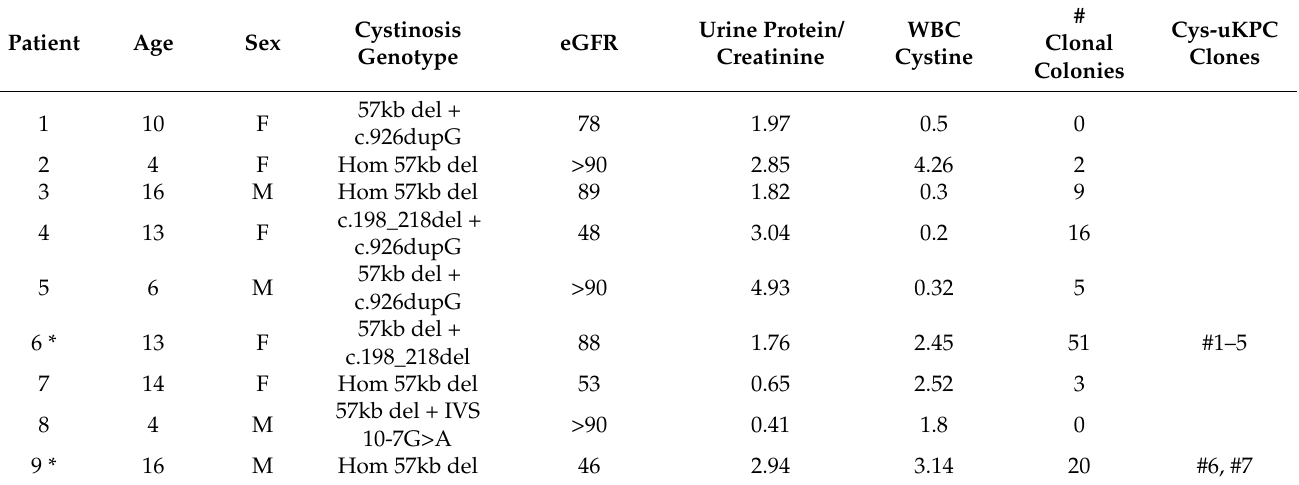
Table 1. Clinical characteristics of the cystinosis patients included in the study at the moment of culturing urine samples in progenitor